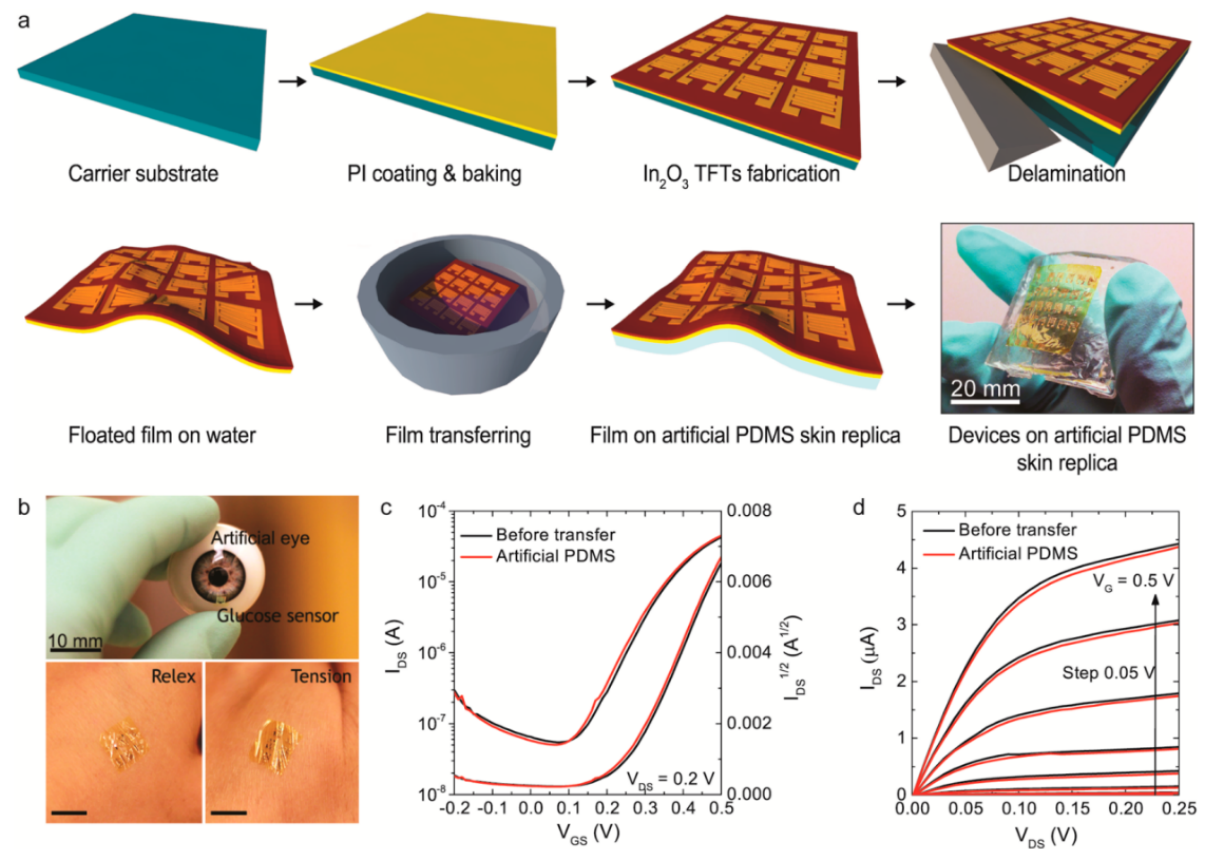
Figure 13. Liquid-gated In 2 O 3 FET-based conformal biosensors. ( a ) Schematic illustration of the flexible biosensor fabrication procedure. Glass substrates were coated with a thin film of PI. Next, In 2 O 3 thin films were deposited over the PI via an aqueous solution-phase spin-coating procedure. The In 2 O 3 thin films were then annealed at 250 ◦ C. Interdigitating Au/Cr electrodes were patterned by photolithography. The PI films with In 2 O 3 FET arrays were delaminated from the underlying glass substrates and floated in water to unroll the films. A synthetic PDMS skin replica was prepared. Thin-film, In 2 O 3 FET sensors were transferred to artificial PDMS skin samples. Ultrathin PI films easily contact uneven artificial skin surfaces. ( b ) Conceptual images of conformally contact devices on an artificial eye for glucose sensing in tears are shown. Thin-film sensors remained in contact with the skin even during tension and relaxation. ( c , d ) Device performance of thin-film In 2 O 3 FETs on rigid substrates and flexible artificial PDMS skin substrates is shown. After the transfer of In 2 O 3 FETs to the skin replica, the devices had similar performance under liquid gating. Low voltage driving and good pinch-off characteristics were observed. Reprinted with permission from Ref. [117]. Copyright 2015 American Chemical